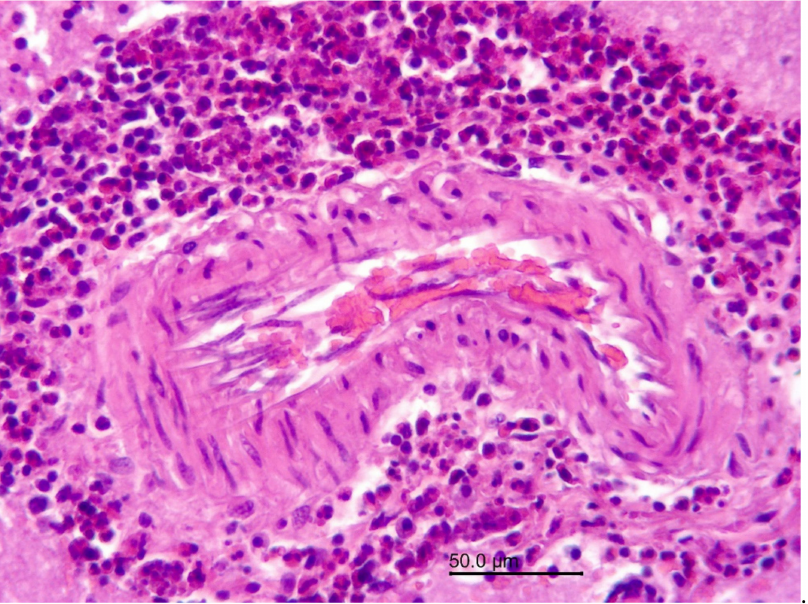
Figure 2. Wapiti, case 1, brain, histopathology, HE, × 200. Blood vessel with a mass of eosinophils in the perivascular space (eosinophilic